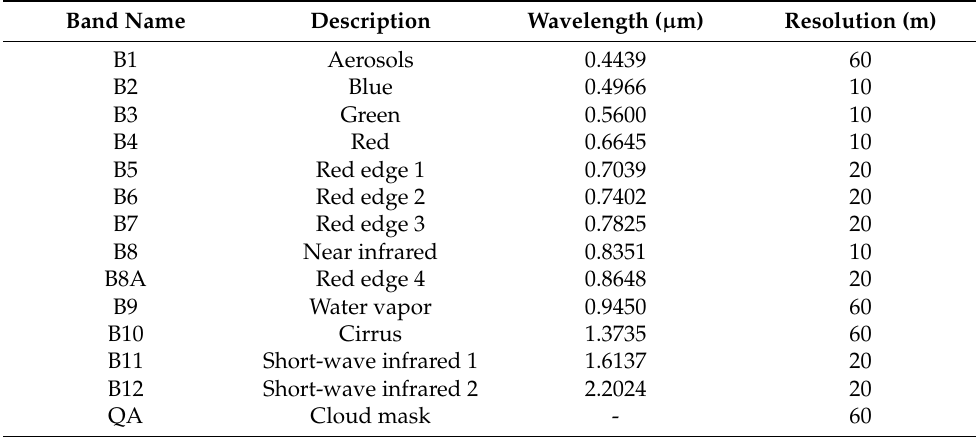
Table 2. Characteristics of the Sentinel-2 Multispectral Instrument